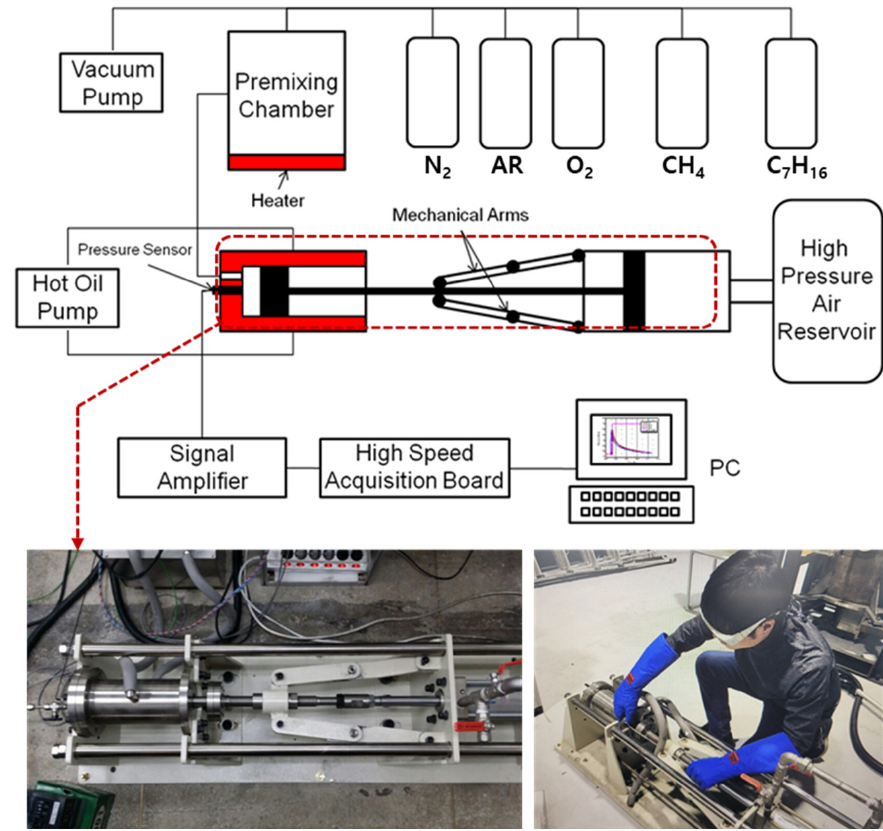
Figure 1. Schematic of the rapid compression machine (RCM) system.